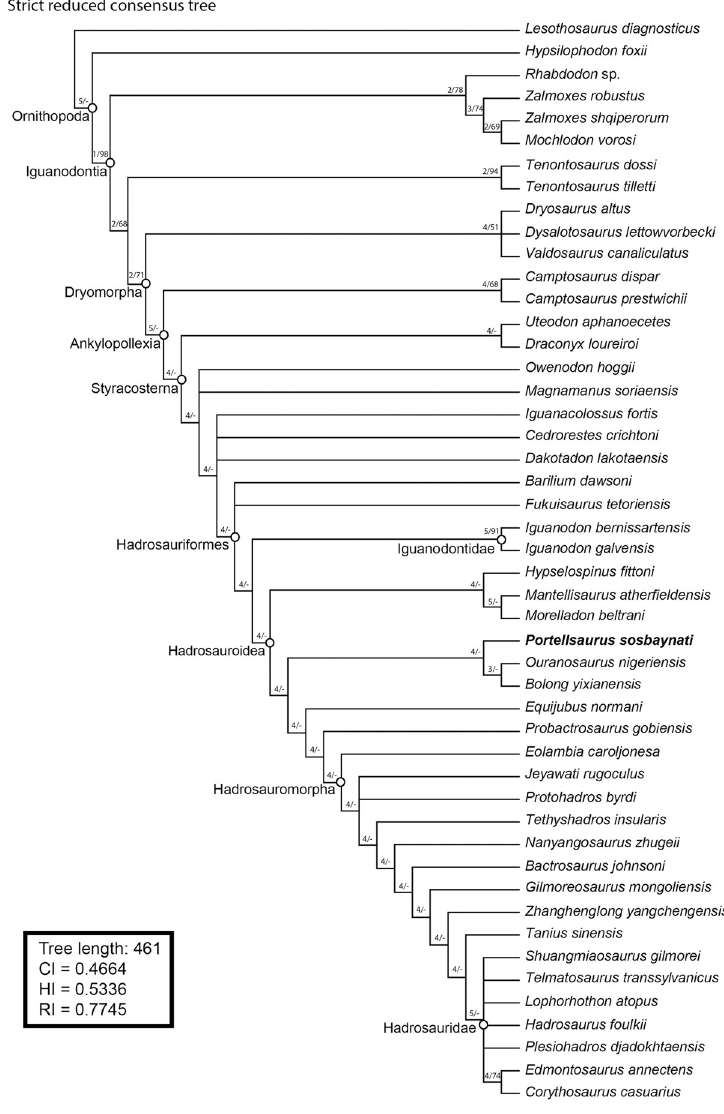
Fig 11. Phylogenetic relationships of Portellsaurus sosbaynati (MQ98-II-1). Strict reduced consensus (IterPCR script) from ordered dataset of 66 OTUs with 461 steps (CI = 0.4664, HI = 0.5336, RI = 0.7745). Notes: Numbers at the left of the node indicate, first, the decay index (Bremer support) and, second, the bootstrapping score obtained for such a node. A hyphen (-) indicates that the node has not been recovered in either the Bremer support analysis or bootstrapping. The phylogenetic position of Portellsaurus sosbaynati is indicated in